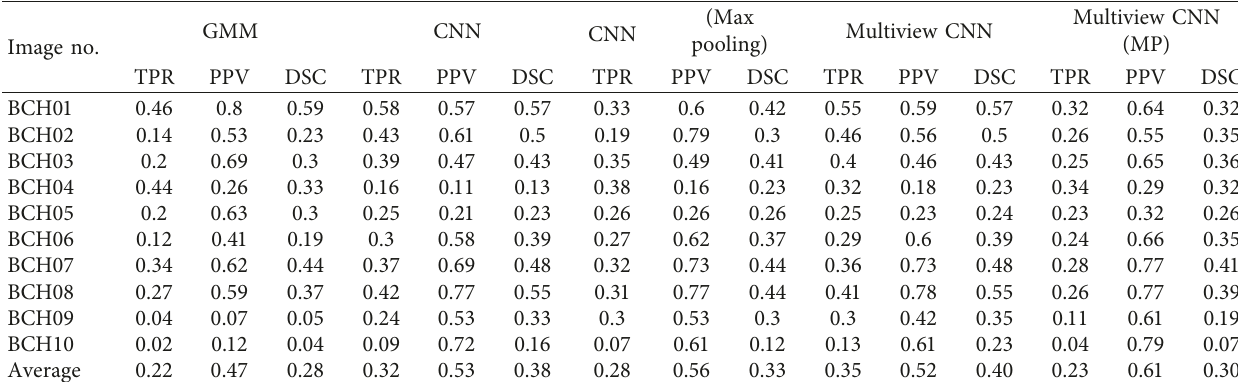
Figure 6: Example of an image in which the automatic segmentation of WM fails. (a) Preprocessed T1 image. (b) Preprocessed T2 image. (c) Preprocessed FLAIR image. (d) WM obtained from K -means. (e) Segmentation delivered by the CHB expert. (f) Segmentation obtained from the GMM. (g) Segmentation obtained by CNN (without max pooling). (h) Segmentation obtained by CNN (with Max pooling). (i) Table 4: Postprocessing